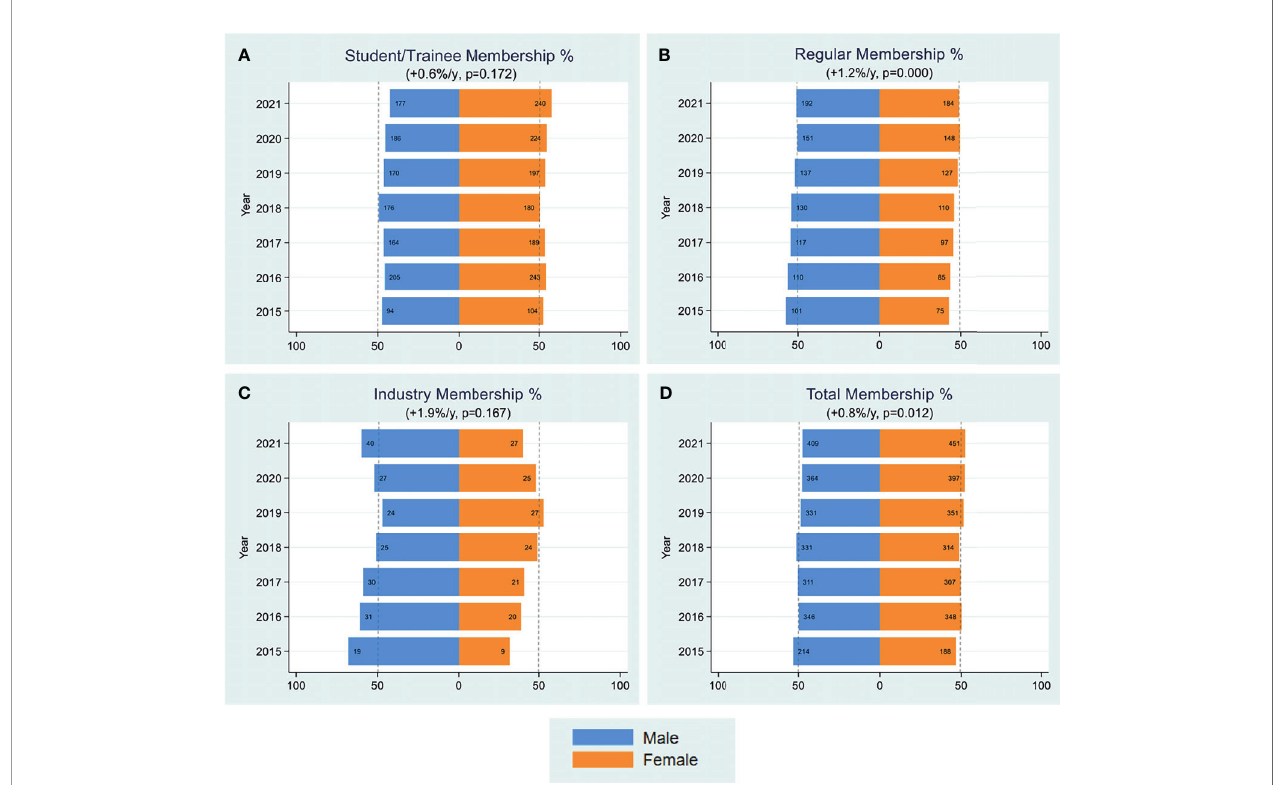
FIGURE 1 | Membership. Yearly female percentages of student/trainee membership (A) , regular membership (B) , industry membership (C) and all categories combined (D) are shown over the period 2015-2021. Percentages were based on actual numbers subjects stating their gender. Average changes per year and p- values (shown in parentheses) were estimated by the slope coef fi cient from a simple linear regression model. The dotted line represents 50% as a point of reference for